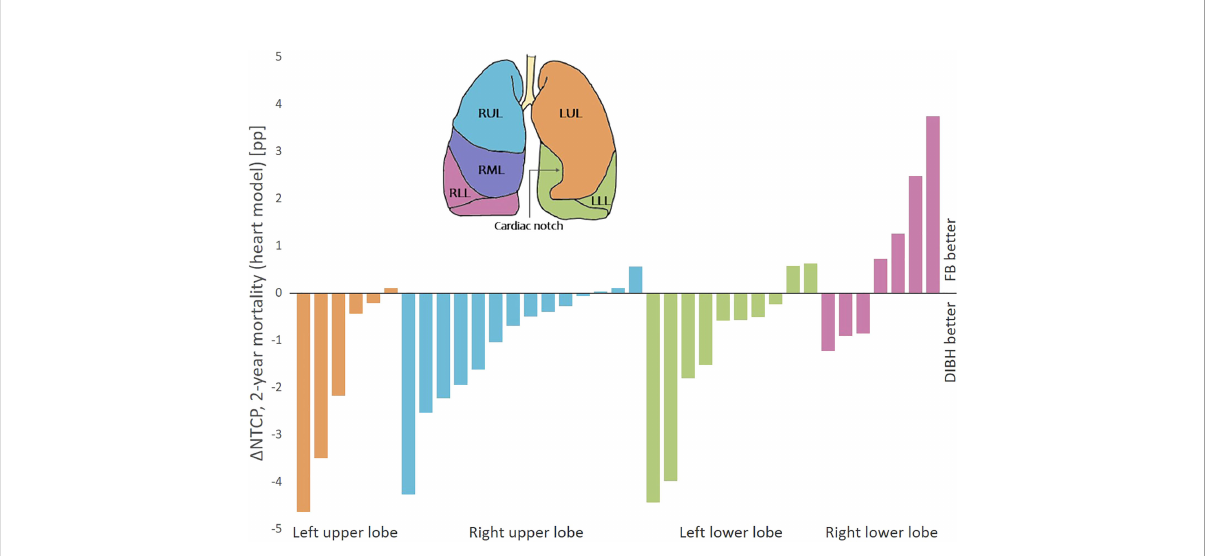
FIGURE 5 D NTCP for 2-year mortality (heart model) between DIBH and FB per patient, sorted according to primary tumor position. There were no patients with primary tumor in the right middle lobe. Negative D NTCP values are in favor of DIBH and positive values are in favor of FB. pp, percentage